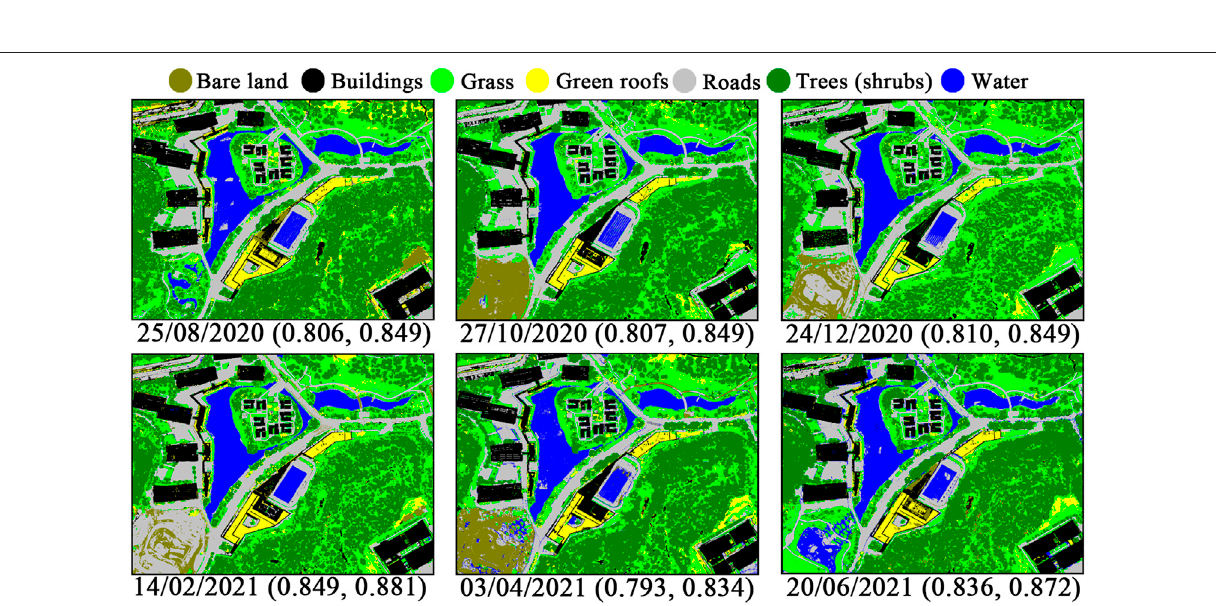
FIGURE 8 | Results for different seasons, and the kappa coef fi cients and